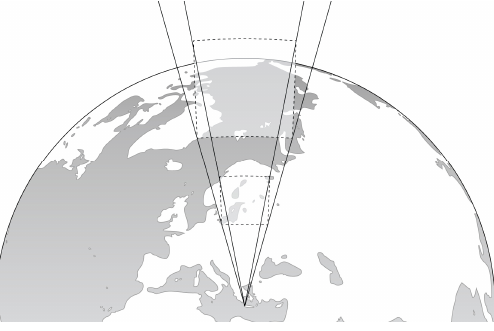
Figure 7. A central principle of 2D land registry systems: from the Earth’s core up to infinity [32 ].